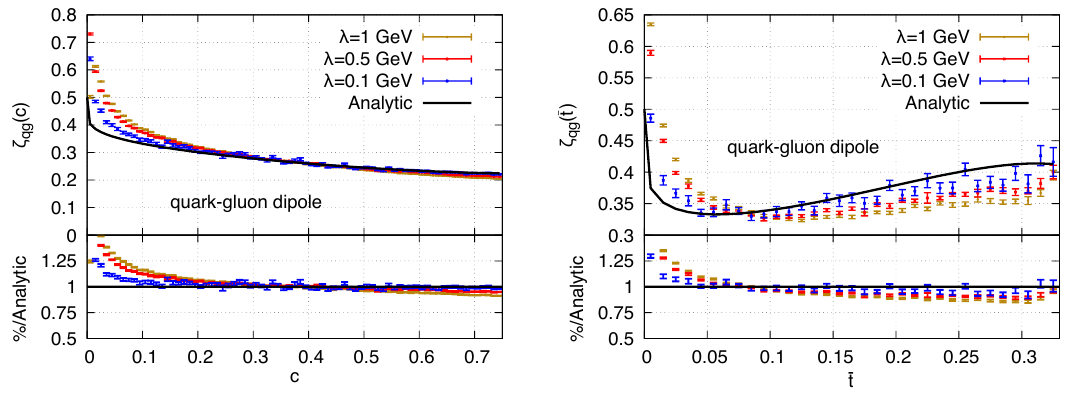
Figure 2 . Same as figure 1, but for the qg dipole.